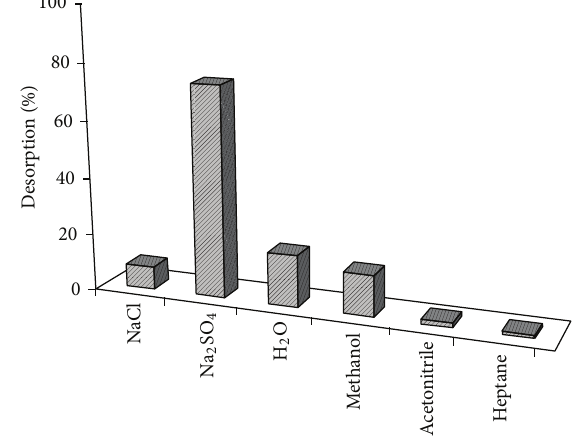
Table 3: Storage